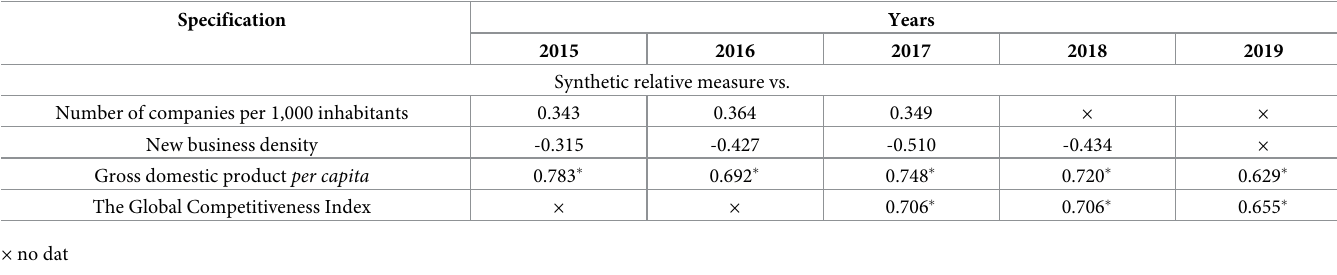
Table 7. Spearman’s correlations coefficient values for the synthetic economic anchor measure and the entrepreneurship index, New business density, Gross domes- tic product per capita and The Global Competitiveness Index.